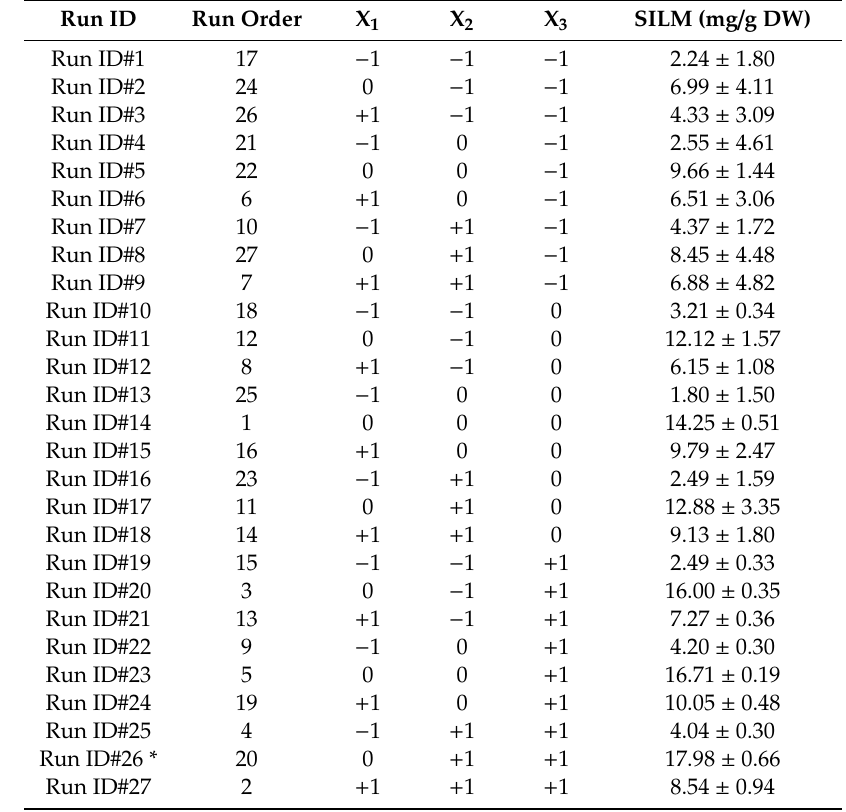
Table 2. Results of full factorial design experiments for the extraction of silymarin (SILM) from mature fruits of S. marianum